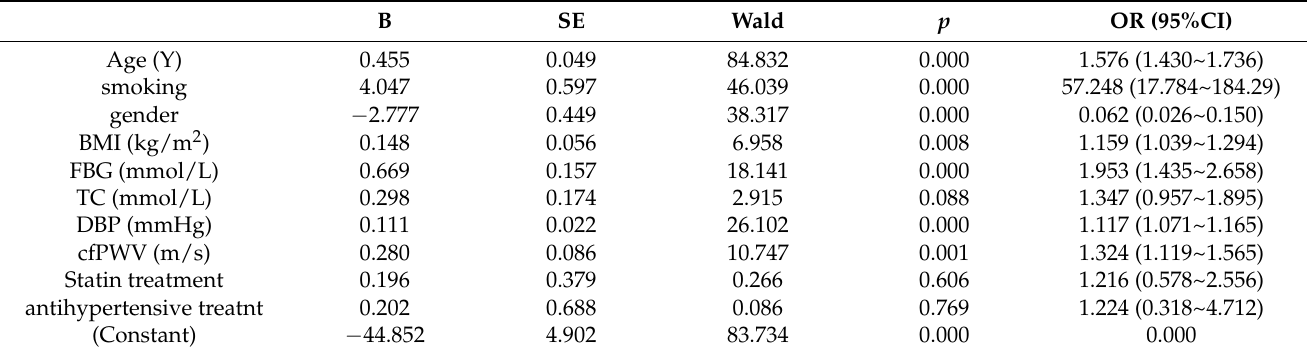
Table 6. Logistic regression analysis between several atherosclerosis risk factors and ASCVD.